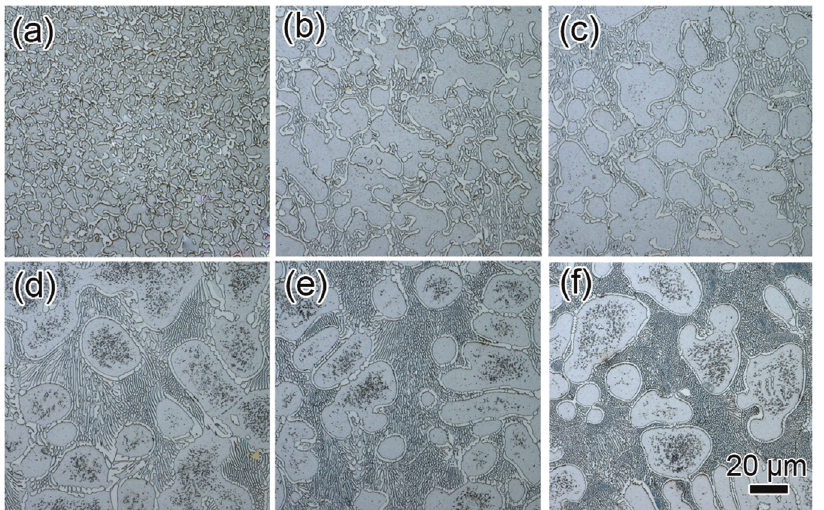
Figure 1: Optical images in different positions of the as-cast Fe-6%Nb alloy: (a) the bottom part of the ingot; (b) and (c) the lower part of the ingot; (d) and (e) the middle part of the ingot; (f) the top part of the